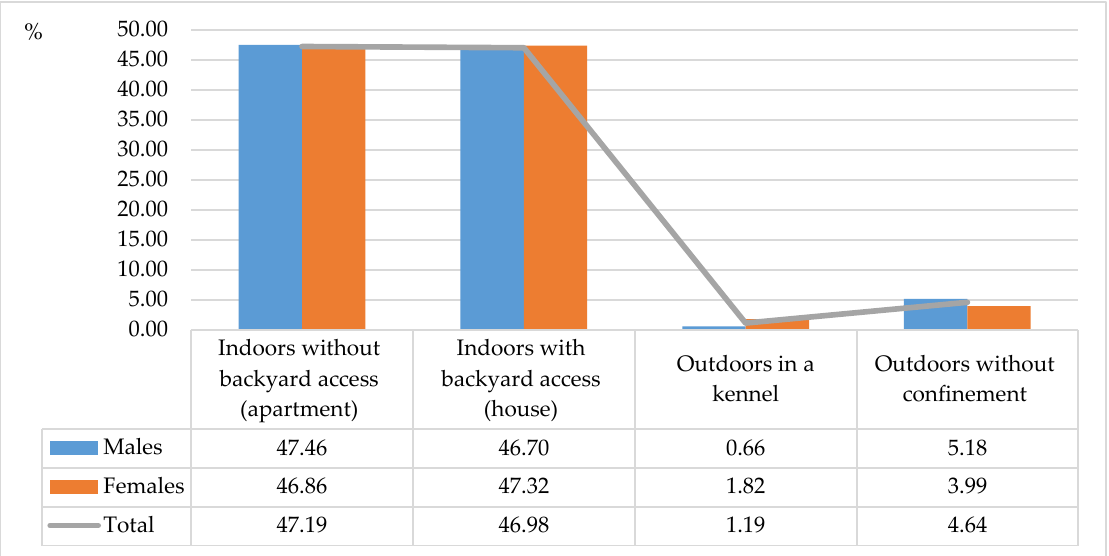
Figure 3. Incidence of undesirable behaviors in dogs living in different housing conditions (%). The incidence of aggressive behavior towards other dogs and animals was analyzed when dogs were walked on a leash, walked off-leash when eating, playing, on their territory, and in other situations (Figure 4). In more than 30% of the examined cases, aggressive behavior was displayed when the dog was walked on a leash. The above scenario accounted for more than 50% of undesirable behaviors in Basenjis. The incidence of aggressive behavior ranged from 2.44% (Samoyeds) to 9.71% (Akitas) when dogs were walked off-leash. Aggressive behaviors towards other animals were also common on a dog’s territory, and they accounted for more than 30% of the cases in Akitas and more than 25% of the cases in Alaskan Malamutes. When asked about other forms of aggression towards other dogs and animals, the respondents claimed that their dogs were aggressive only in response to aggressive behavior displayed by other dogs. In some cases, dogs were aggressive to strangers who approached the owner (for example, during a walk), which was perceived probably as a potential threat by the dog.